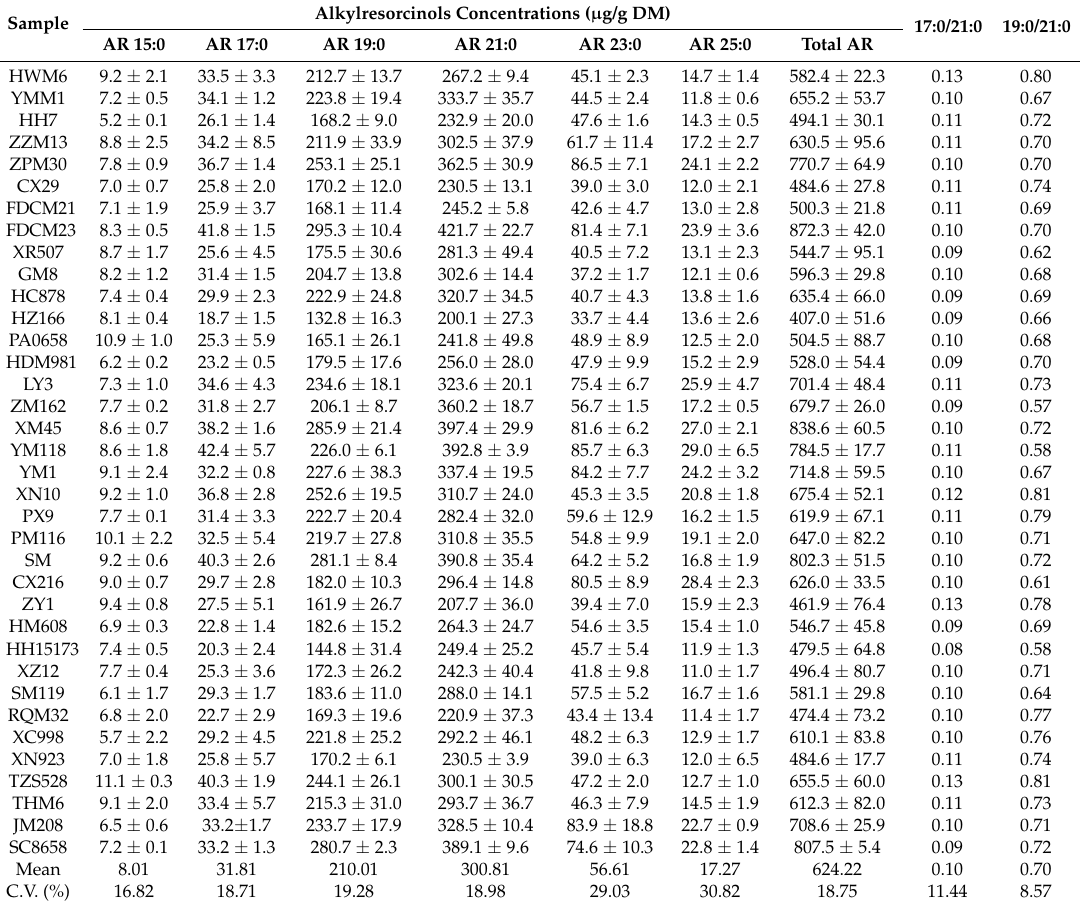
Table A3. Total ARs and their homologues concentrations in whole grains from 36 wheat samples cultivated in 2017 in